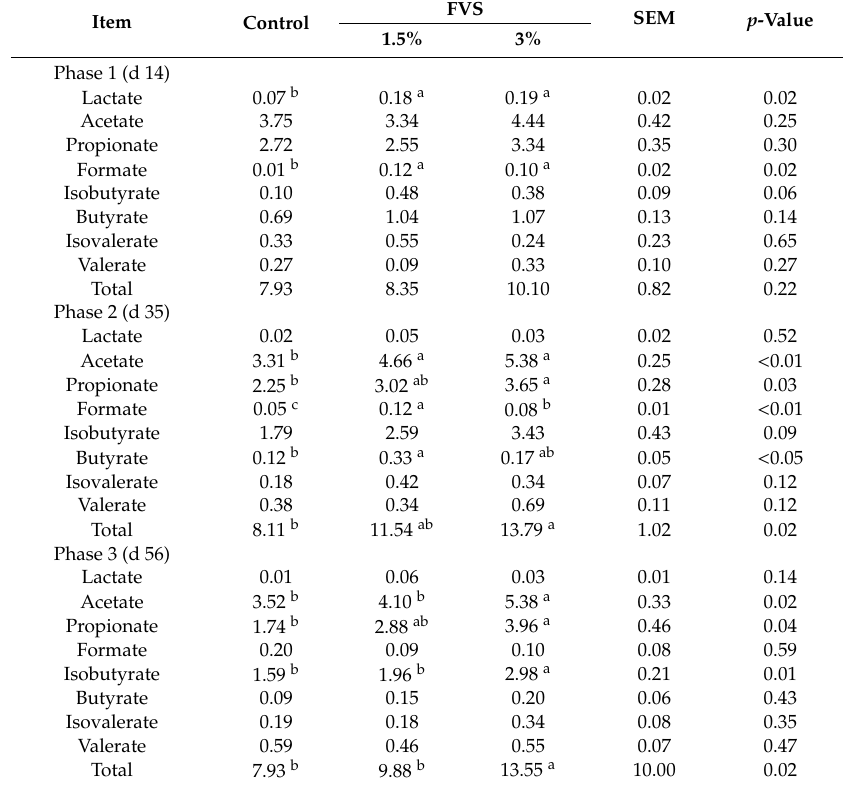
Table 9. E ff ects of dietary Flammulina velutipes stem waste (FVS) supplementation on short chain fatty acids (SCFAs) production measured in fresh feces of piglets on day 14, day 28 and day 56 (mg / g) (Exp.2).